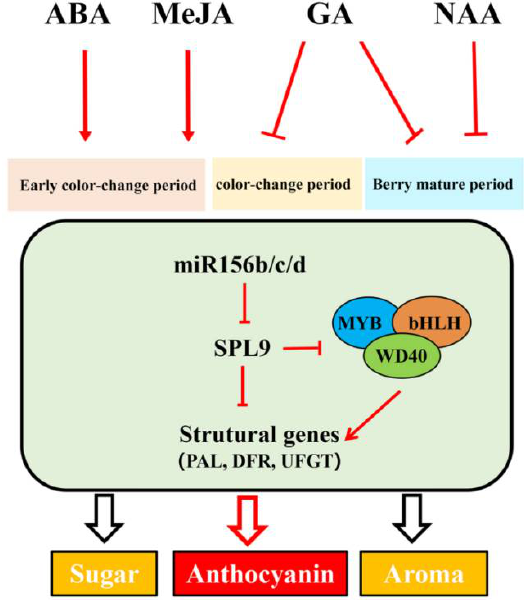
Figure 9. The network of anthocyanins regulated by VvmiR156b/c/d- VvSPL9 responds to hor- mones.